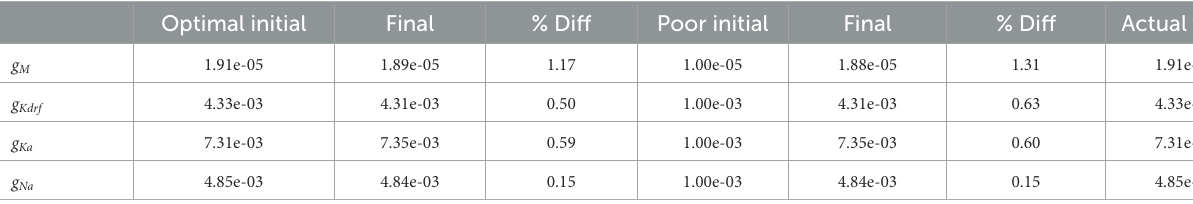
TABLE 2 Using SINGLE for experimental observations.